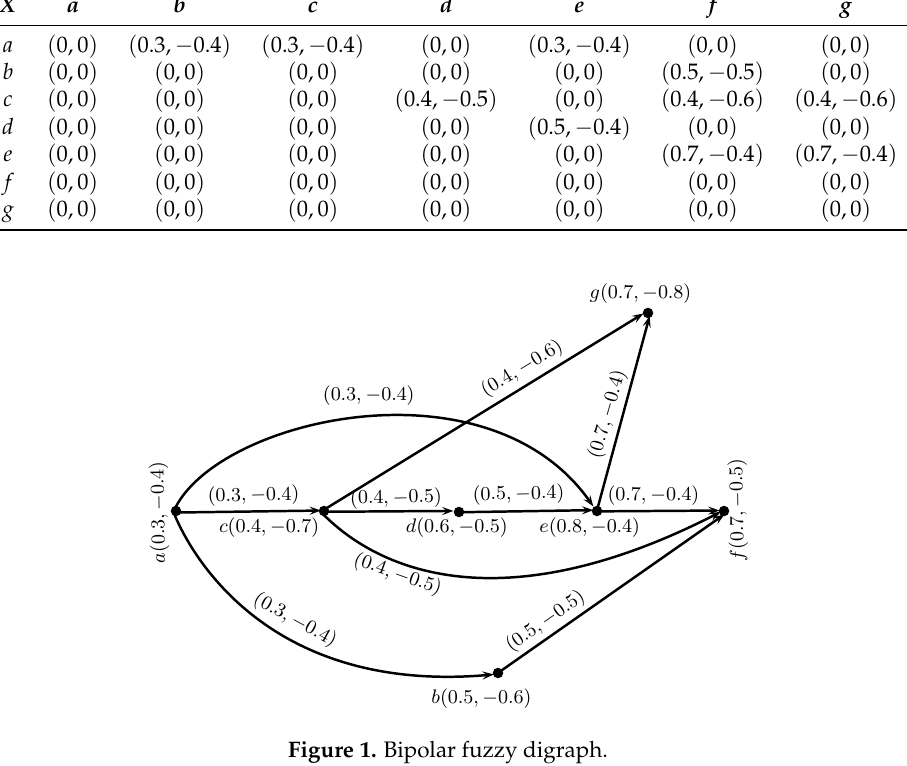
Figure 2.2: Bipolar fuzzy competition graph